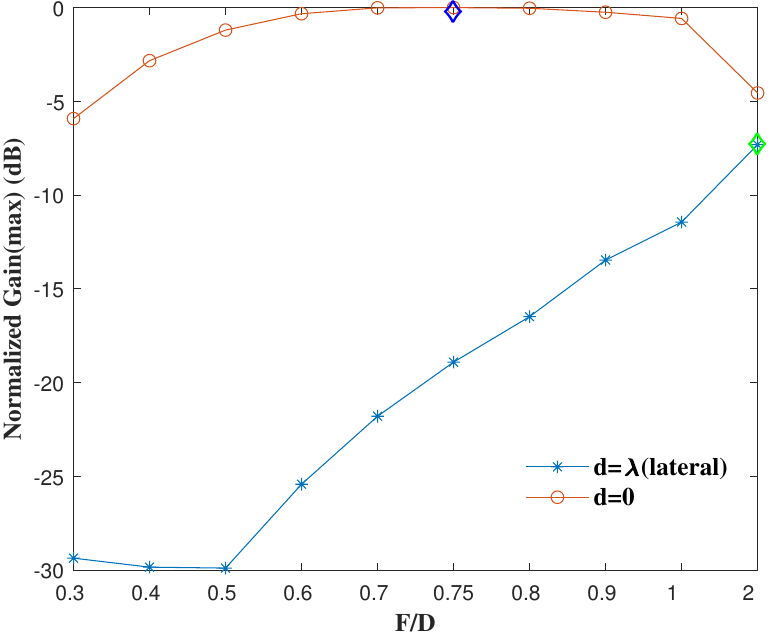
Figure 8. Peak gain of each F / D with d = λ (lateral) and d =